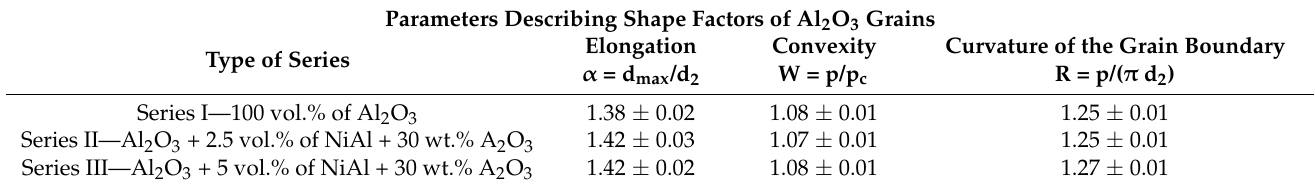
Table 4. Parameters describing shape factors of the Al 2 O 3 grains in the samples.